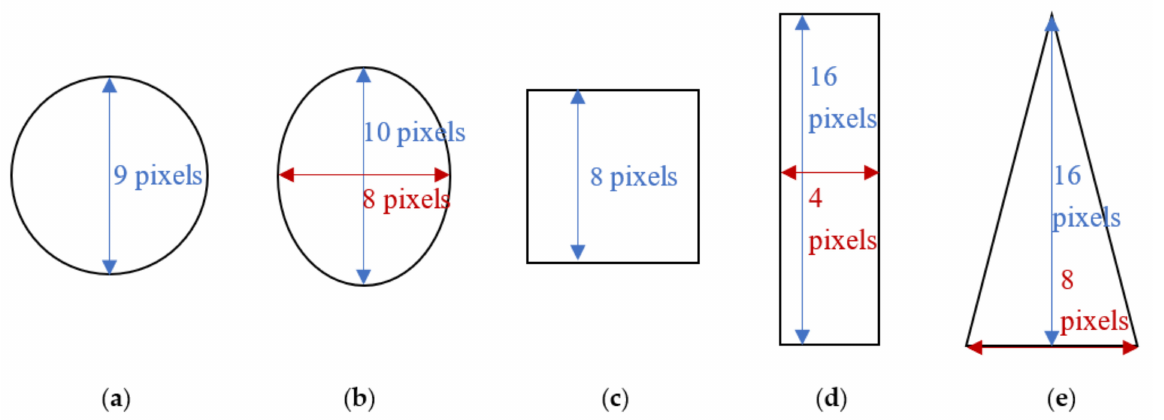
Figure 4. Shapes of the simulated microchannels with a 64 pixel 2 (0.2273 mm 2 ) cross-sectional area. ( a – e ): circular, oval, square, rectangular, triangular.